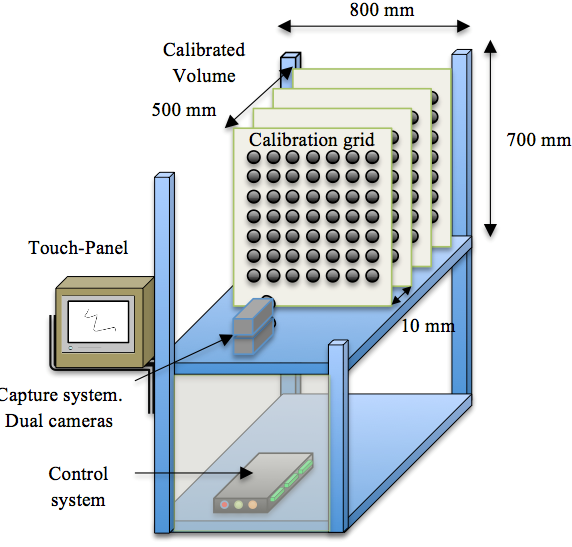
Figure 5. Calibration planes used to obtain real measurements from the growth chamber.